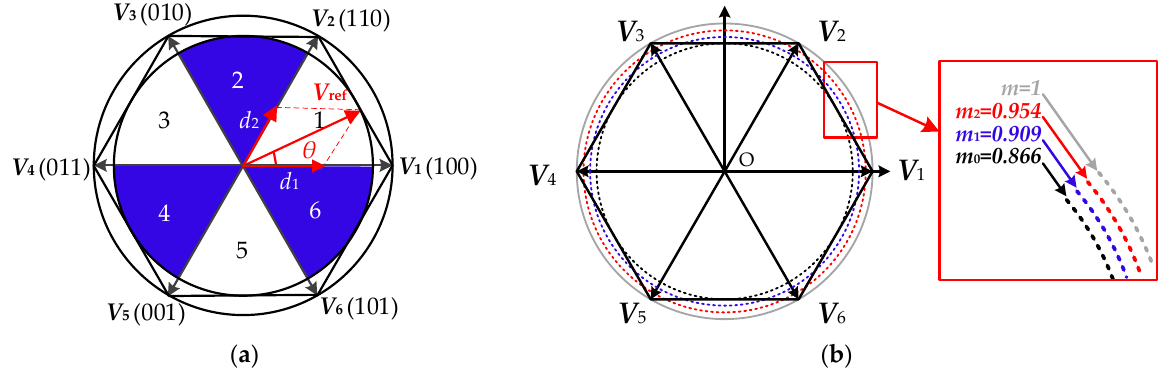
Figure 1. Vector diagram: ( a ) space vector modulation strategy of the VSI; ( b ) equivalent vector circles under different modulation ratios.